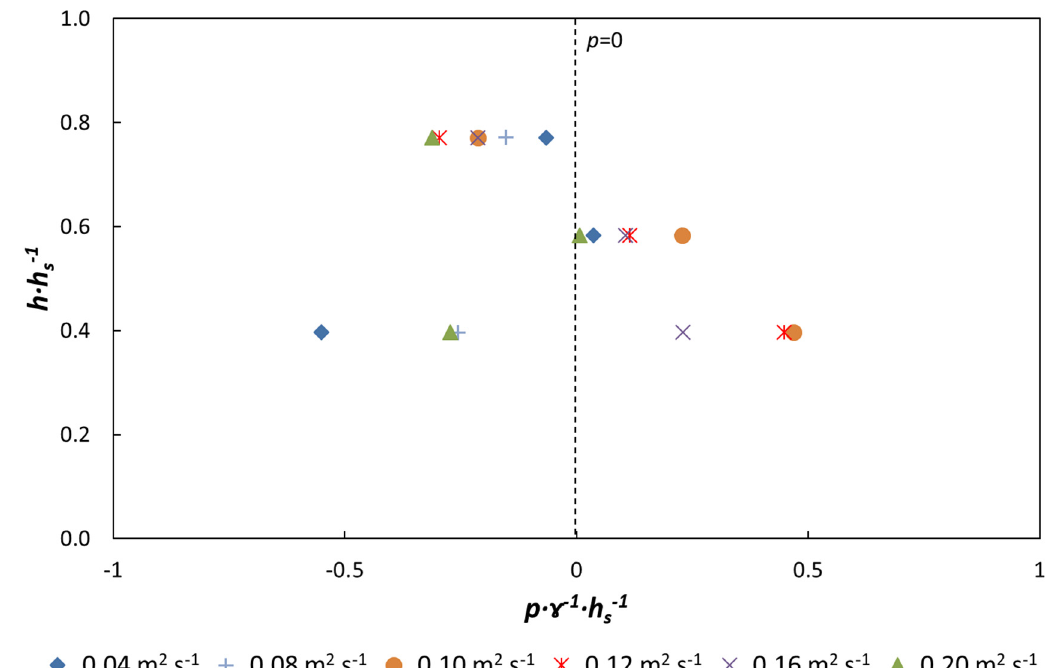
Figure 18. The average of the hydrodynamic pressures registered on the block riser of the Armorwedge TM block ( w 1) in row 25 of the chute for different unit discharges simulating free drainage conditions ( d 1).